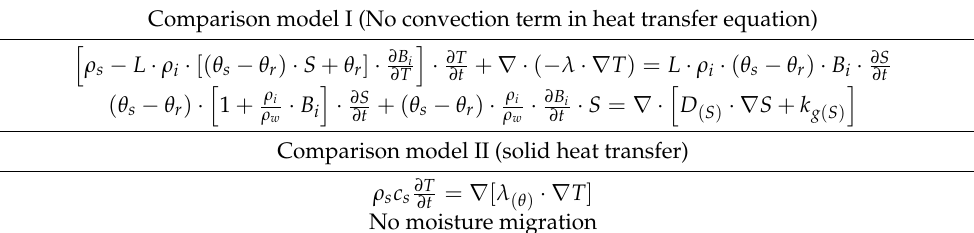
Table 3. Two contrasting models. Comparison model I (No convection term in heat transfer